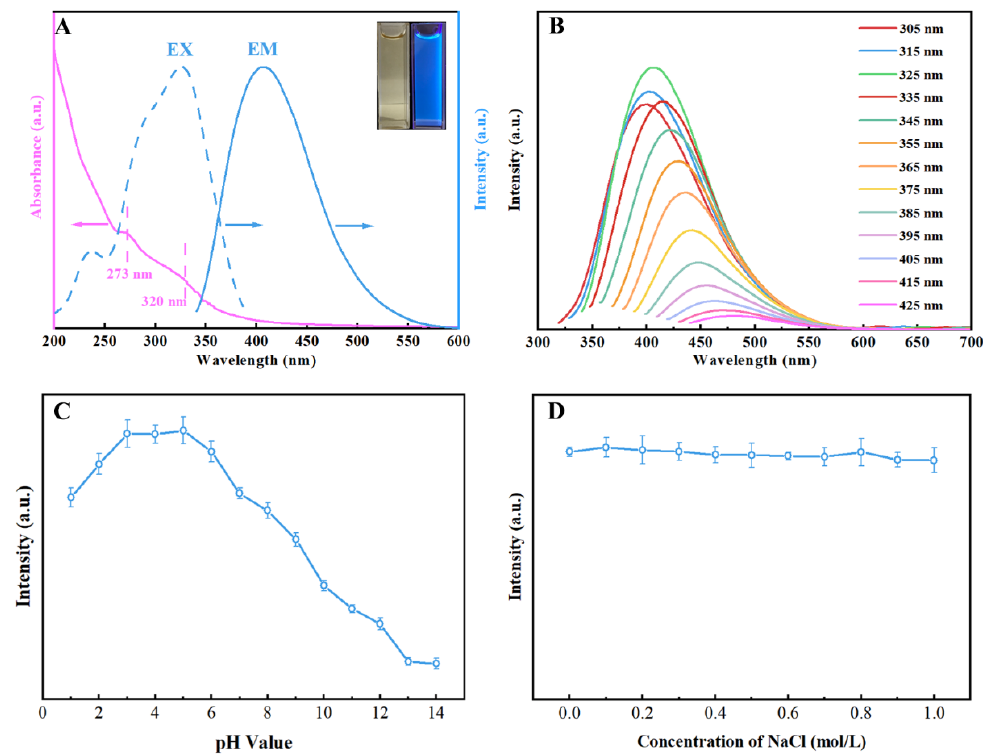
Figure 4. UV − vis absorption spectra of N, S-CDs and the excitation/emission fluorescence spectra of N, S-CDs. The top right inset shows the digital photographs of the N, S-CDs solutions under daylight and UV radiation at 365 nm ( A ); fluorescence emission spectra of N, S-CDs at different ranges of excitation wavelengths ( B ); fluorescence intensity of N, S-CDs at different pH values ( C ); and various concentrations of NaCl ionic solutions ( D ).